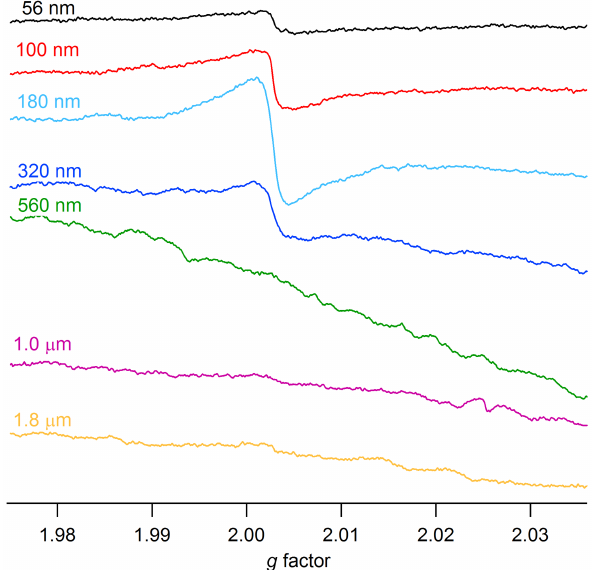
Figure 1. Electron paramagnetic resonance (EPR) spectra of atmo- spheric aerosol impactor samples with lower cut-off diameters in the range of 56nm to 1.8µm collected in Mainz, Germany, during 26–27 June, 2015.